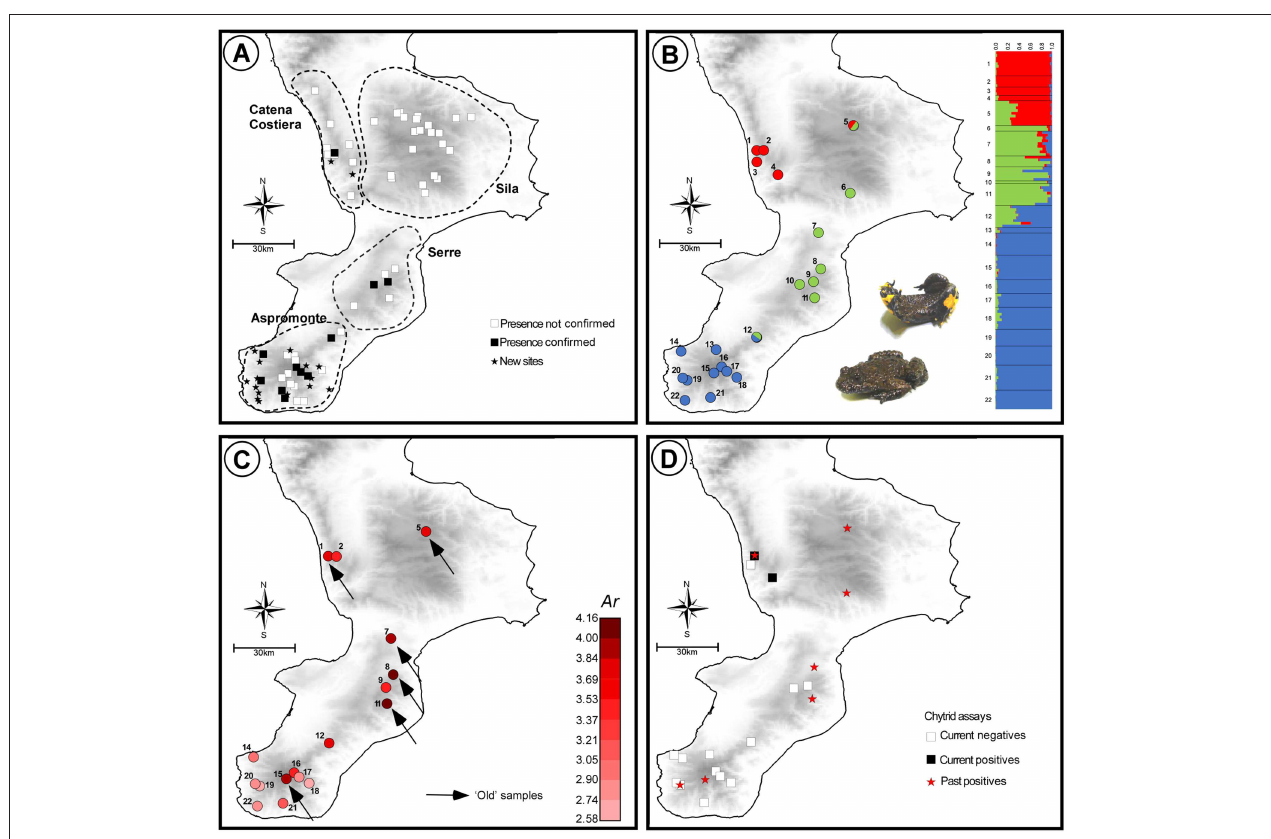
FIGURE 1 | Spatial and temporal patterns of variation in species presence, genetic diversity, and chytrid occurrence, for the Apennine yellow-bellied toad in southern Italy (Calabria region). Sources of historical data and samples are reported within the main text. (A) Sites of past and current presence of Bombina pachypus in the area; dashed shapes show the four subregions considered in this study. (B) Results of the Bayesian clustering analysis used to assess the population genetic structure of B. pachypus in the area; admixture proportions of each sampled individual for the 3 genetic clusters identified as the best clustering option by the method implemented in TESS. (C) Geographic variation in estimates of genetic diversity (A r : allelic richness), among populations of B. pachypus sampled either for the present study or in the past. (D) Past and current presence of the chytrid pathogen Batrachochytrium dendrobatidis among the sampled populations of B. pachypus from the study